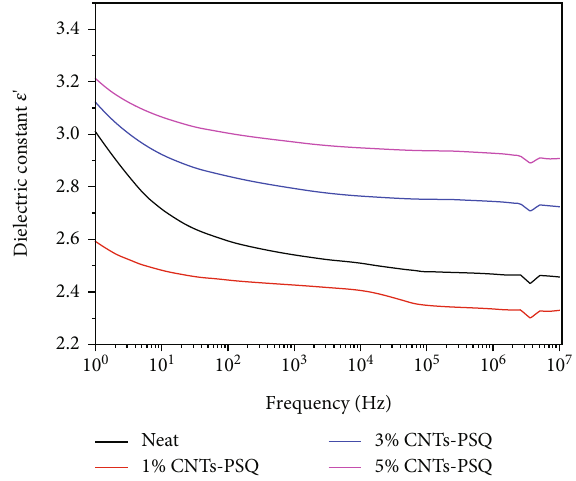
Figure 6: Dielectric constant ε ′ versus frequency for the nanocomposites with various addition of